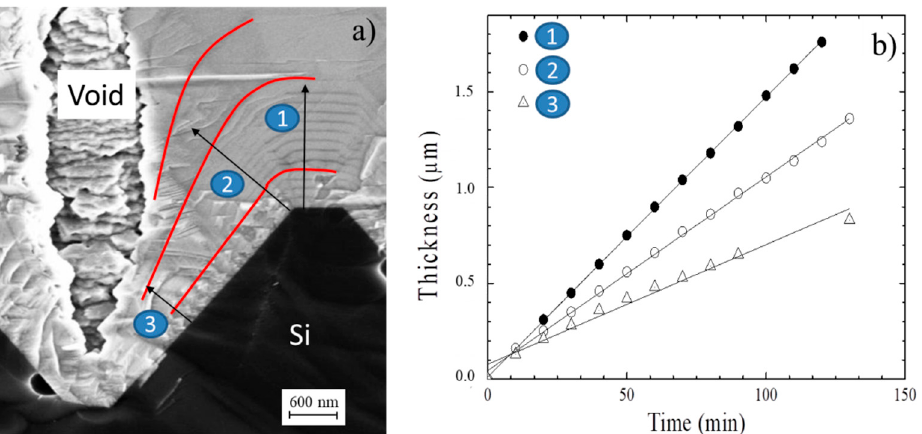
Figure 7. ( a ) SEM cross-section of the pyramid showing the void and the N + markers. Red lines are drawn as a guide for the eyes. In the same image three black straight lines are drawn: Line 1 is related to the growth of (001) SiC plane, while lines 2 and 3 refer to the growth of (111) plane in two di ff erent positions of the pyramid; ( b ) The thickness of the epilayer as a function of growth time for line 1, 2, and 3 of the Figure a.